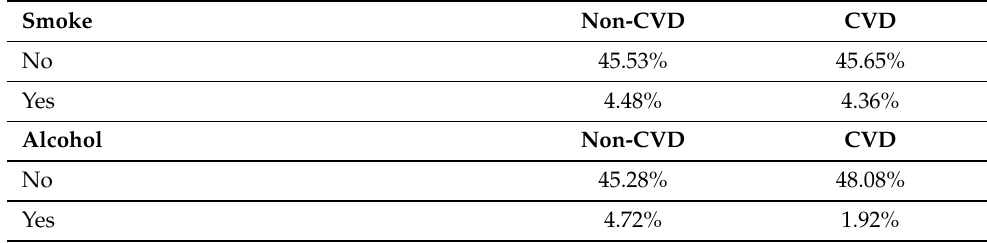
Table 7. Participants’ distribution per smoking and alcohol status in the balanced dataset.